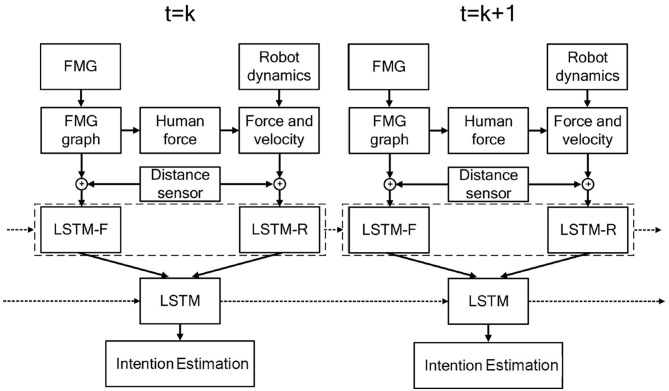
Block diagram of the information flow in two consecutive time steps.